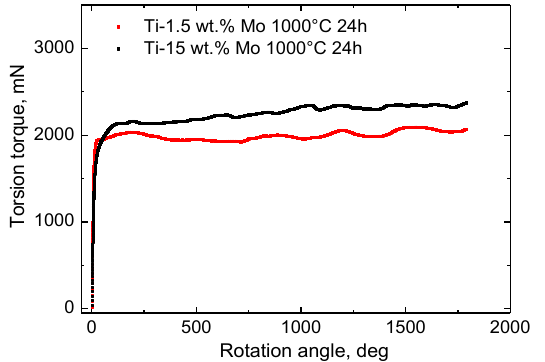
Figure 5. Dependence of the torsion torque during HPT on the rotation angle for the Ti–1.5 wt.% Mo (bottom curve, red) and Ti–15 wt.% Mo (top curve, black) alloys.